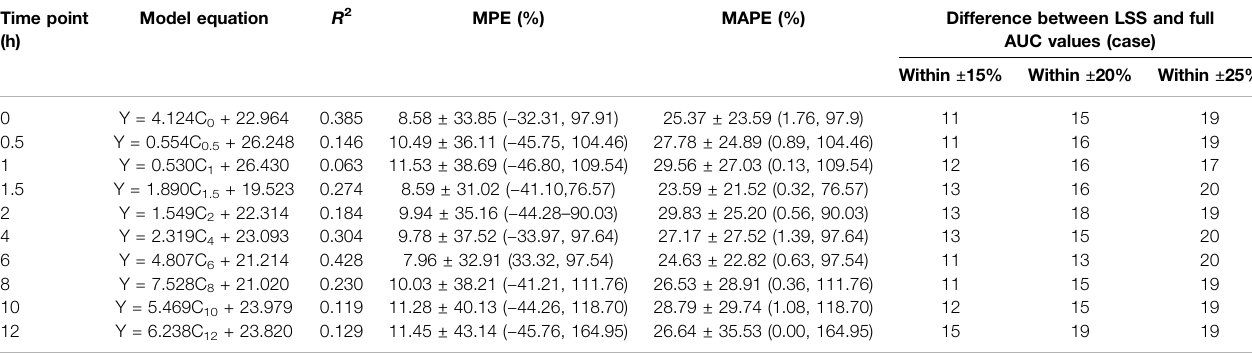
TABLE 3 | Univariate correlation between the MPA plasma concentration at each time point and MPA-AUC 0 – 12 h ( n (cid:1) 30). Time point Model equation (h)